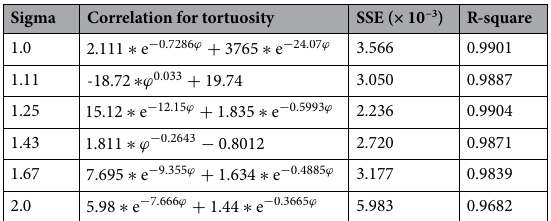
Table 3. Empirical tortuosity–porosity relations for Porous media.